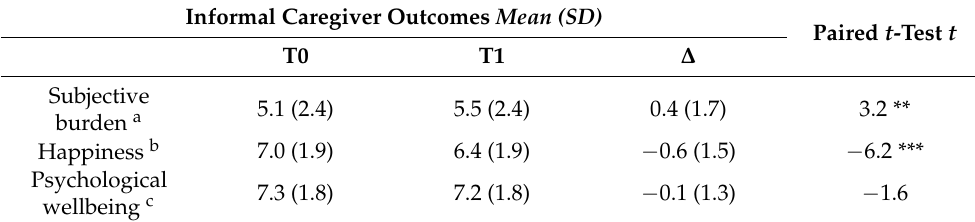
Table 3. Informal Caregiver Outcomes at T0 and T1 ( n =